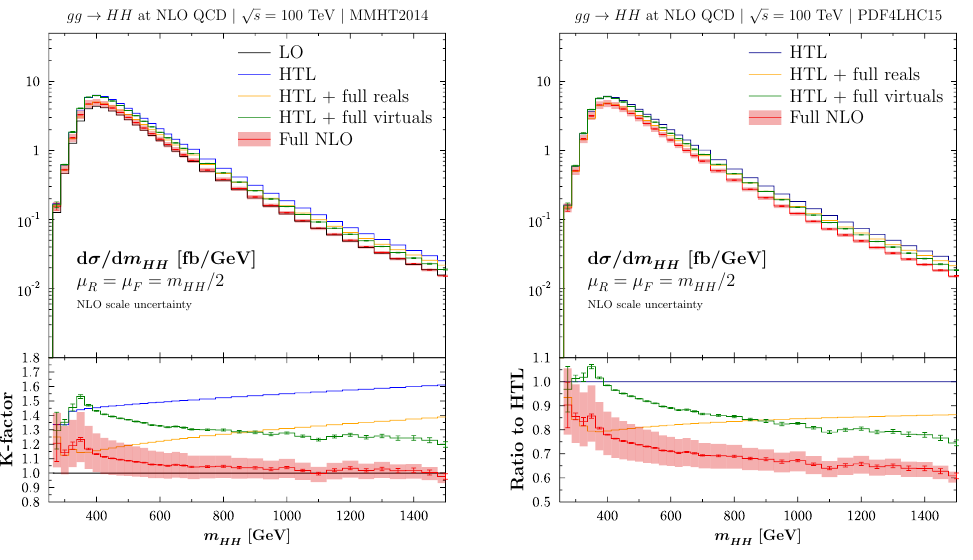
Figure 12 . Same as (cid:12)gure 10 but for a c.m. energy p s = 100